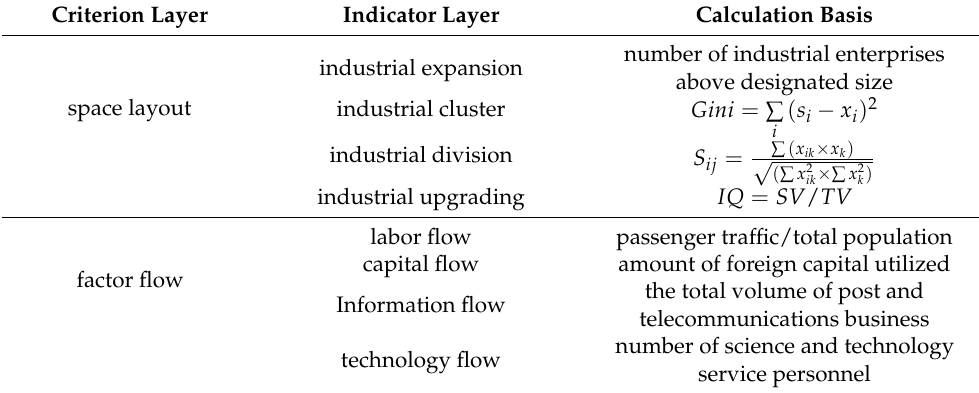
Table 1. Industry integration index